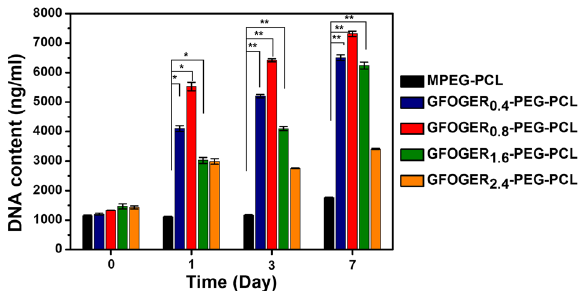
Fig. 4 The in fl uence of GFOGER on the proliferation of BMSCs. DNA quanti fi cation cultured BMSCs in hydrogels was assessed for 7 days with picogreen assay (Data were shown as mean ± SD, unpaired Student ’ s t -test. * p < 0.05 and ** p <